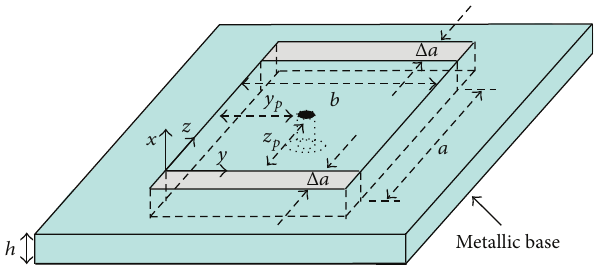
Figure 2: Cavity-backed probe-fed hybrid microstrip